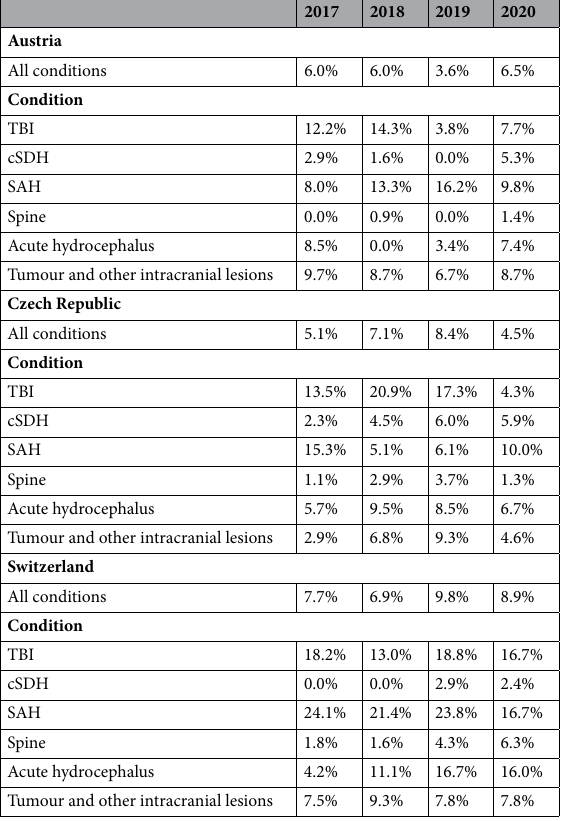
Table 3. The 30-day mortality rates from non-elective neurosurgical cases in Austria, Czech Republic and Switzerland from 2017–2020. TBI Traumatic brain injury, cSDH chronic subdural hematoma, SAH subarachnoid haemorrhage and other vascular